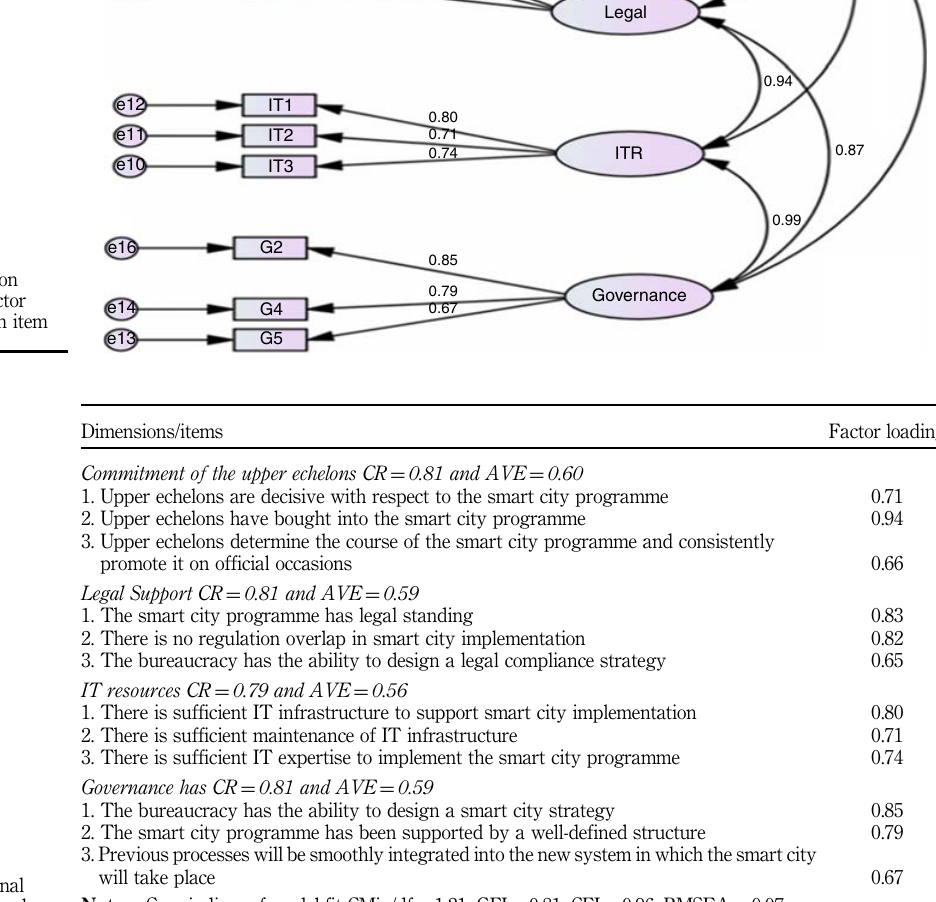
Table III. Summary of final measurement